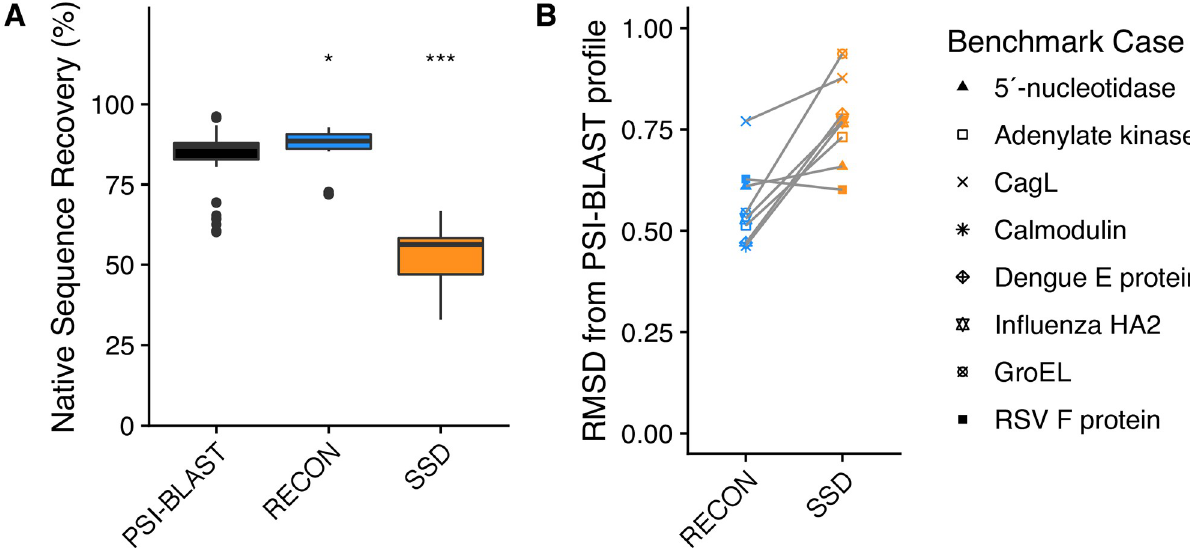
Fig 3. Design native sequence recovery and mutation profile variability comparisons to PSI-BLAST profiles. (A) Comparison of total native sequence recovery of relaxed and unminimized RECON MSD and SSD designs to PSI-BLAST sequence profiles generated using the native sequence. For this figure and all subsequent boxplots, shaded regions of each box plot denote values within the first and third quartiles (interquartile range, or IQR ), with the median indicated as a solid line and whiskers representing values ± 1.5 × IQR . Outliers are represented as dots. Asterisks indicate the significance of difference of means of each design in comparison to the PSI-BLAST profile, with a z -test p -value < 0.01 represented by one asterisk, and a p -value < 0.00001 by three asterisks. The p -value provided in this figure and all subsequent figures represents a two-sided, 95% confidence interval. (B) Mutation frequency root mean square deviations of designs in comparison to a PSI-BLAST profile. The y-axis values represent the root mean square deviation (RMSD) of mutation profiles for each designed residue in relation to a PSI-BLAST profile, represented as: y ¼ where aa j represents the frequency of an amino acid observed at position i for each of all twenty amino acids ( j ), and y is the sum of all i differences for all amino acids within a protein of length n residues. A y-value of 0 would indicate that the design profile is identical to the PSI-BLAST profile, and an increase in y-value indicates the root mean square deviation of the sequence profile for each residue is more dissimilar to a PSI-BLAST